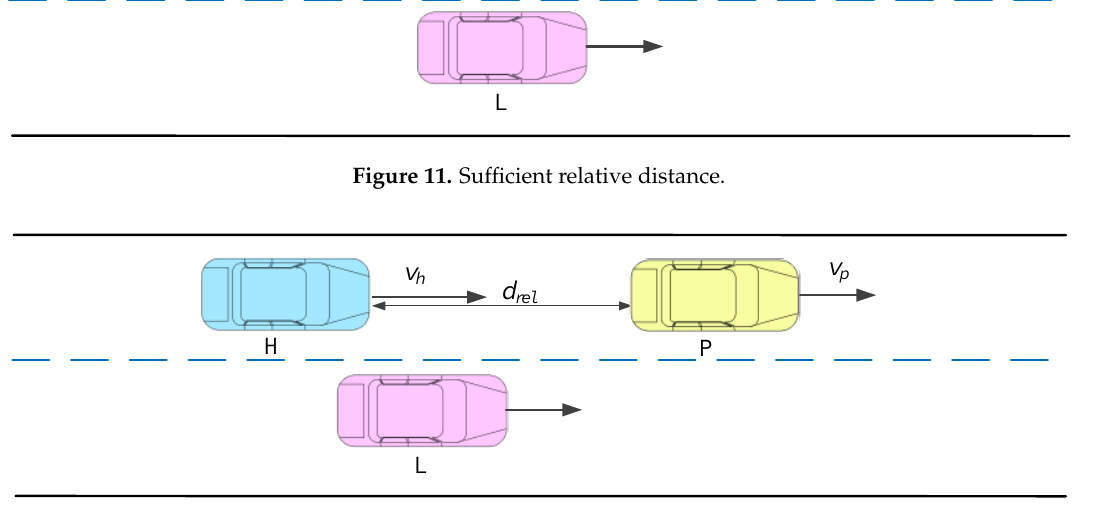
Figure 12. Insufficient relative distance.